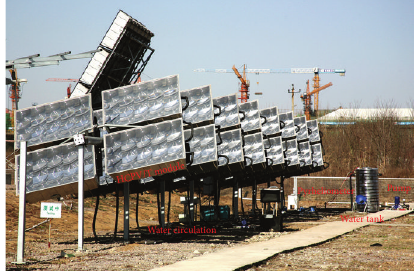
Figure 1: Photograph of the 30kW HCPV/T system.